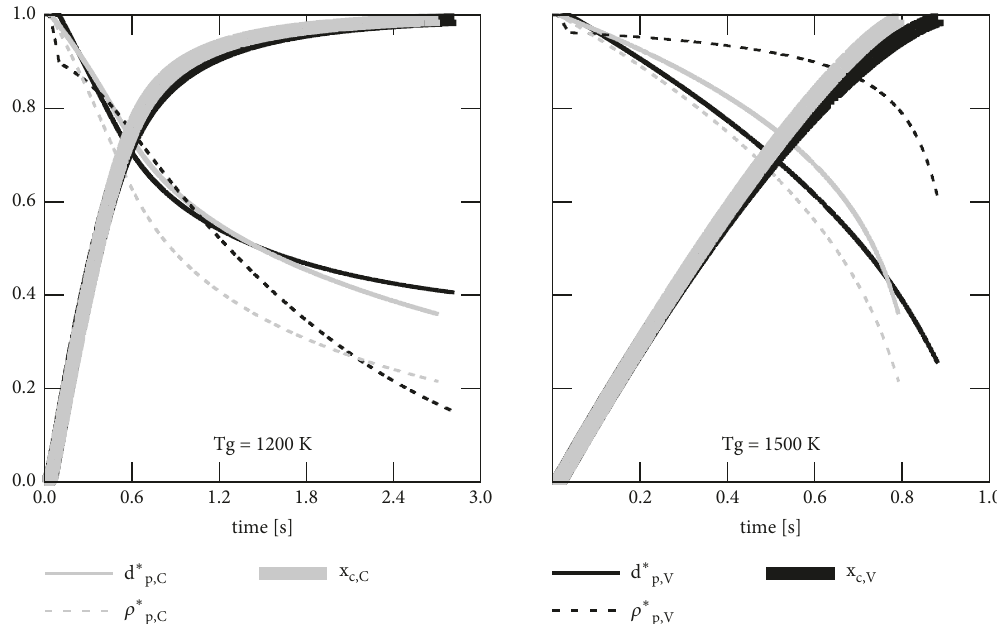
Figure 6: Time evolution of char conversion conversion ( 𝑥 𝑐 ), normalised diameter ( 𝑑 ∗ 𝑝 = 𝑑 𝑝 /𝑑 𝑝,0 ), and normalised density ( 𝜌 ∗ 𝑝 = 𝜌 𝑝 /𝜌 𝑝,0 ) of a single particle char immersed in an atmosphere with 6 % O 2 at 1200K. The subscripts C and V denote constant conversion mode and variable conversion mode, respectively.